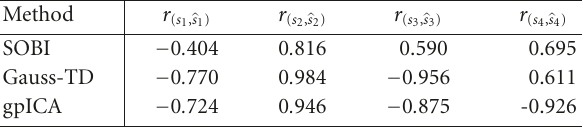
Table 2: Experiment 3: mixture of four speech signals—correlation coe ffi cient between the original sources and their